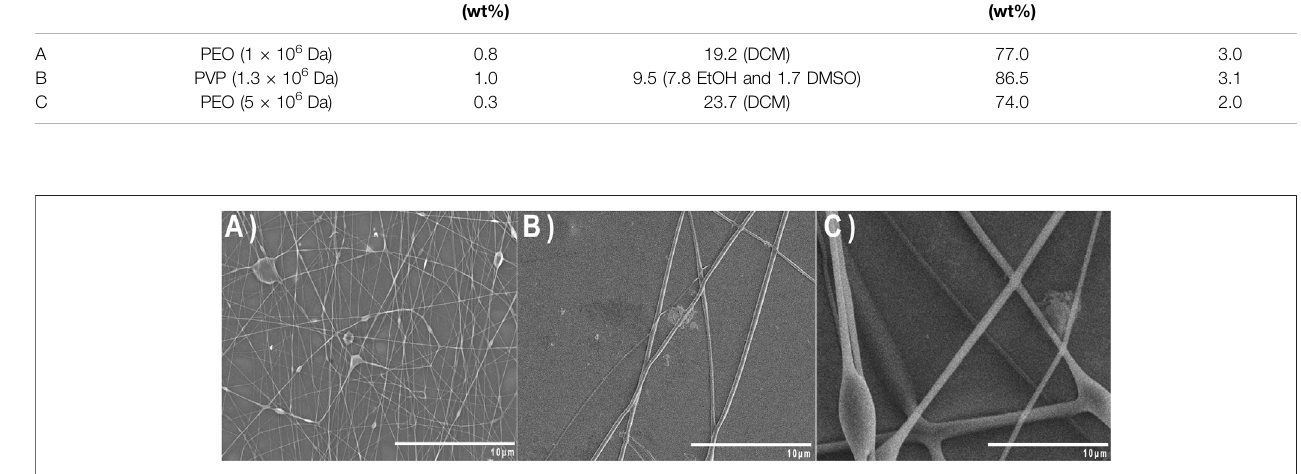
FIGURE 2 | SEM pictures of the fi bers from the mixtures A (A) , B (B) and C (C) after 700 s of electrospinning.